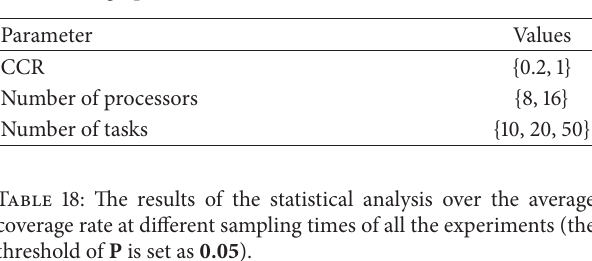
Table 17: Configuration parameters of convergence experiment for the random graphs.